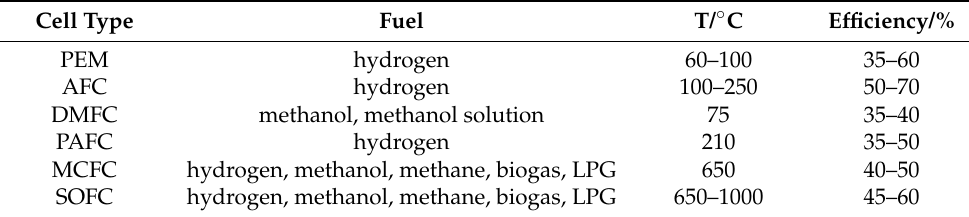
Table 3. Temperature limits of the systems